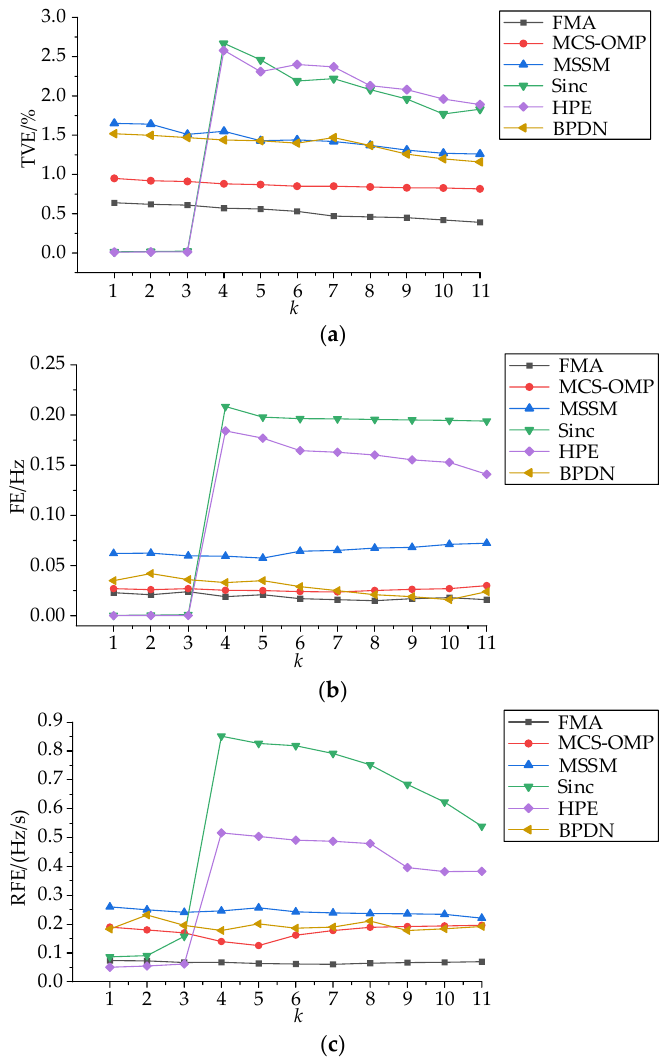
Figure 3. Running results of each algorithm: ( a ) TVE values for each algorithm; ( b ) FE values for each algorithm; ( c ) RFE values for each algorithm.